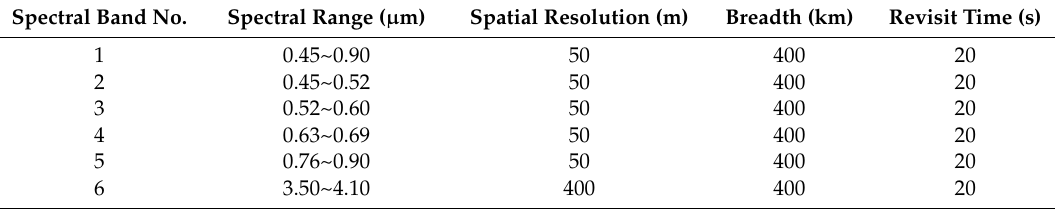
Table 2. Technical indicators of the GF-4 satellite